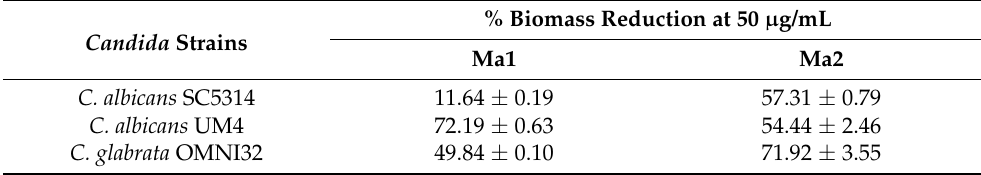
Table 3. In vitro activity of Ma1 and Ma2 against mature Candida